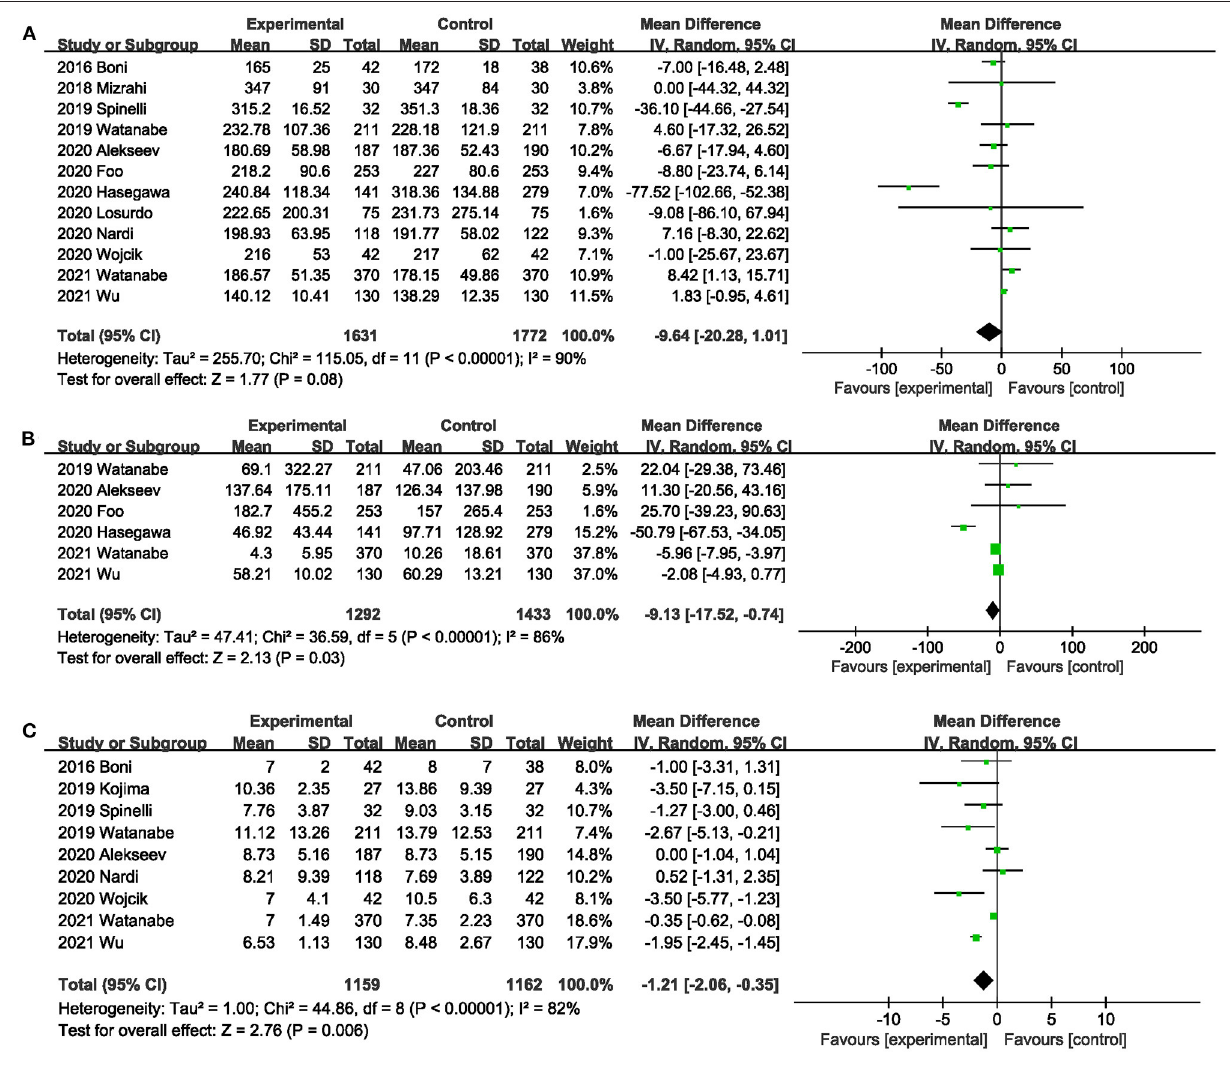
FIGURE 9 | Effect of indocyanine green on (A) Operative time. (B) Blood loss during surgery. (C) Length of postoperative hospital